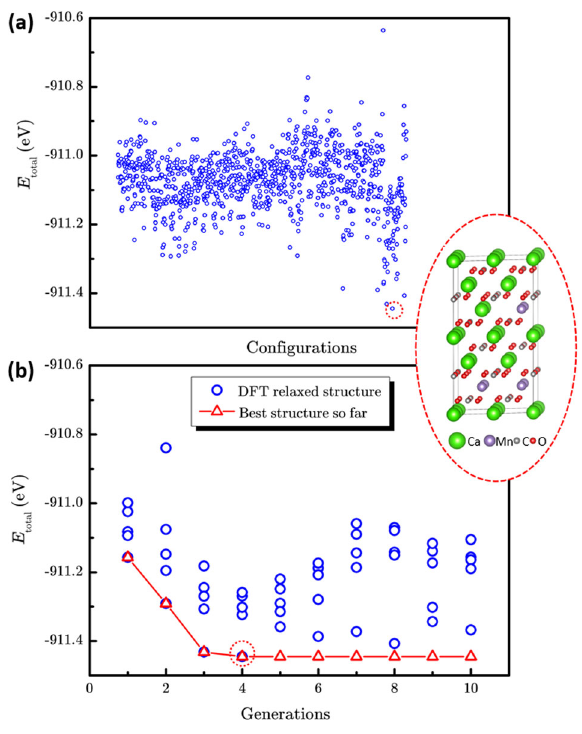
Fig. 2 The performance of enumeration method and LAsou method for Ca 1 − x Mn x CO 3 (x = 0.25). a The scatter plot of total energy of 1033 enumerated structures and the most stable structure. b The searching process of LAsou method for the total DFT energy against with